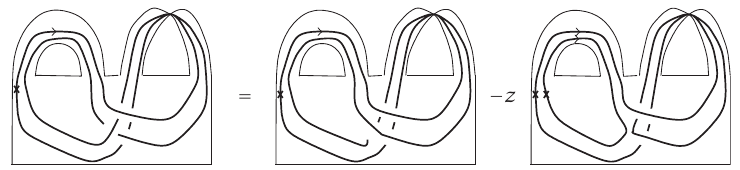
Figure 5.4 . What is ∇ (K